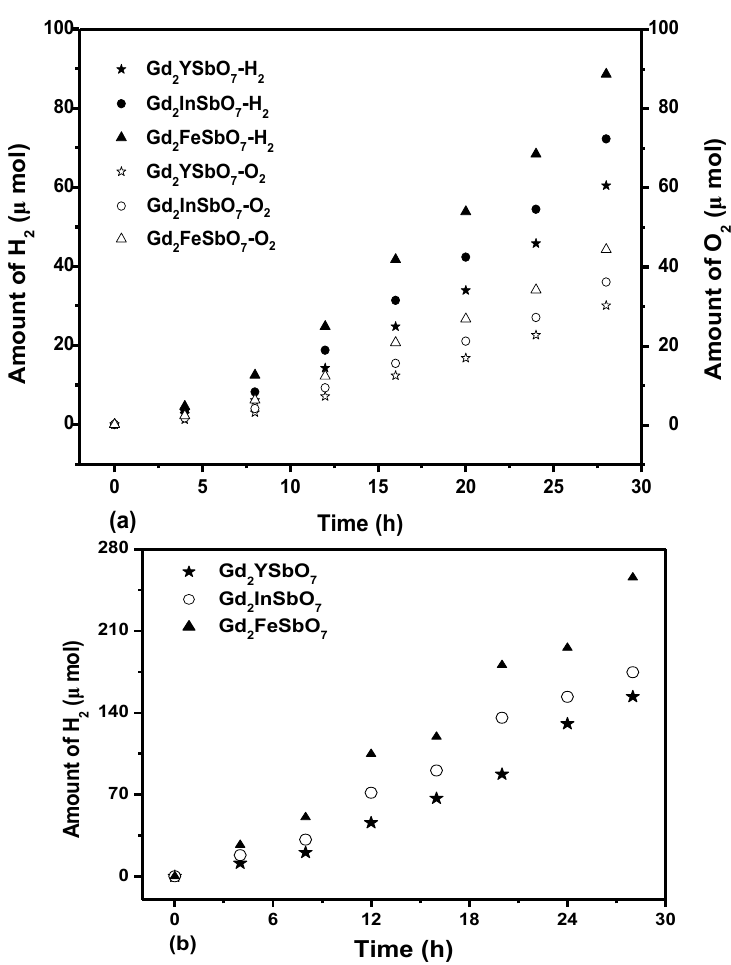
Figure 3. ( a ) Photocatalytic H 2 evolution and photocatalytic O 2 evolution from pure water with Gd 2 FeSbO 7 , Gd 2 InSbO 7 or Gd 2 YSbO 7 as catalyst under visible light irradiation (λ > 420 nm, 0.5 g powder sample, 250 mL pure water). Light source: 300 W Xe lamp; ( b ) Photocatalytic H 2 evolution from aqueous methanol solution with Gd 2 FeSbO 7 , Gd 2 InSbO 7 or Gd 2 YSbO 7 as catalyst under visible light irradiation (λ > 420 nm, 0.5 g 0.1 wt% Pt-loaded powder sample, 50 mL methanol solution, 200 mL pure water). Light source: 300 W Xe